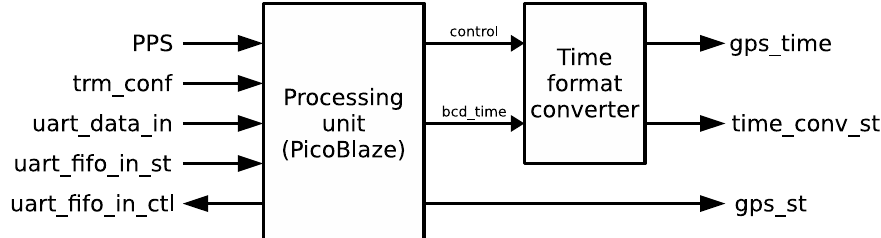
Figure 6. Time reception module block